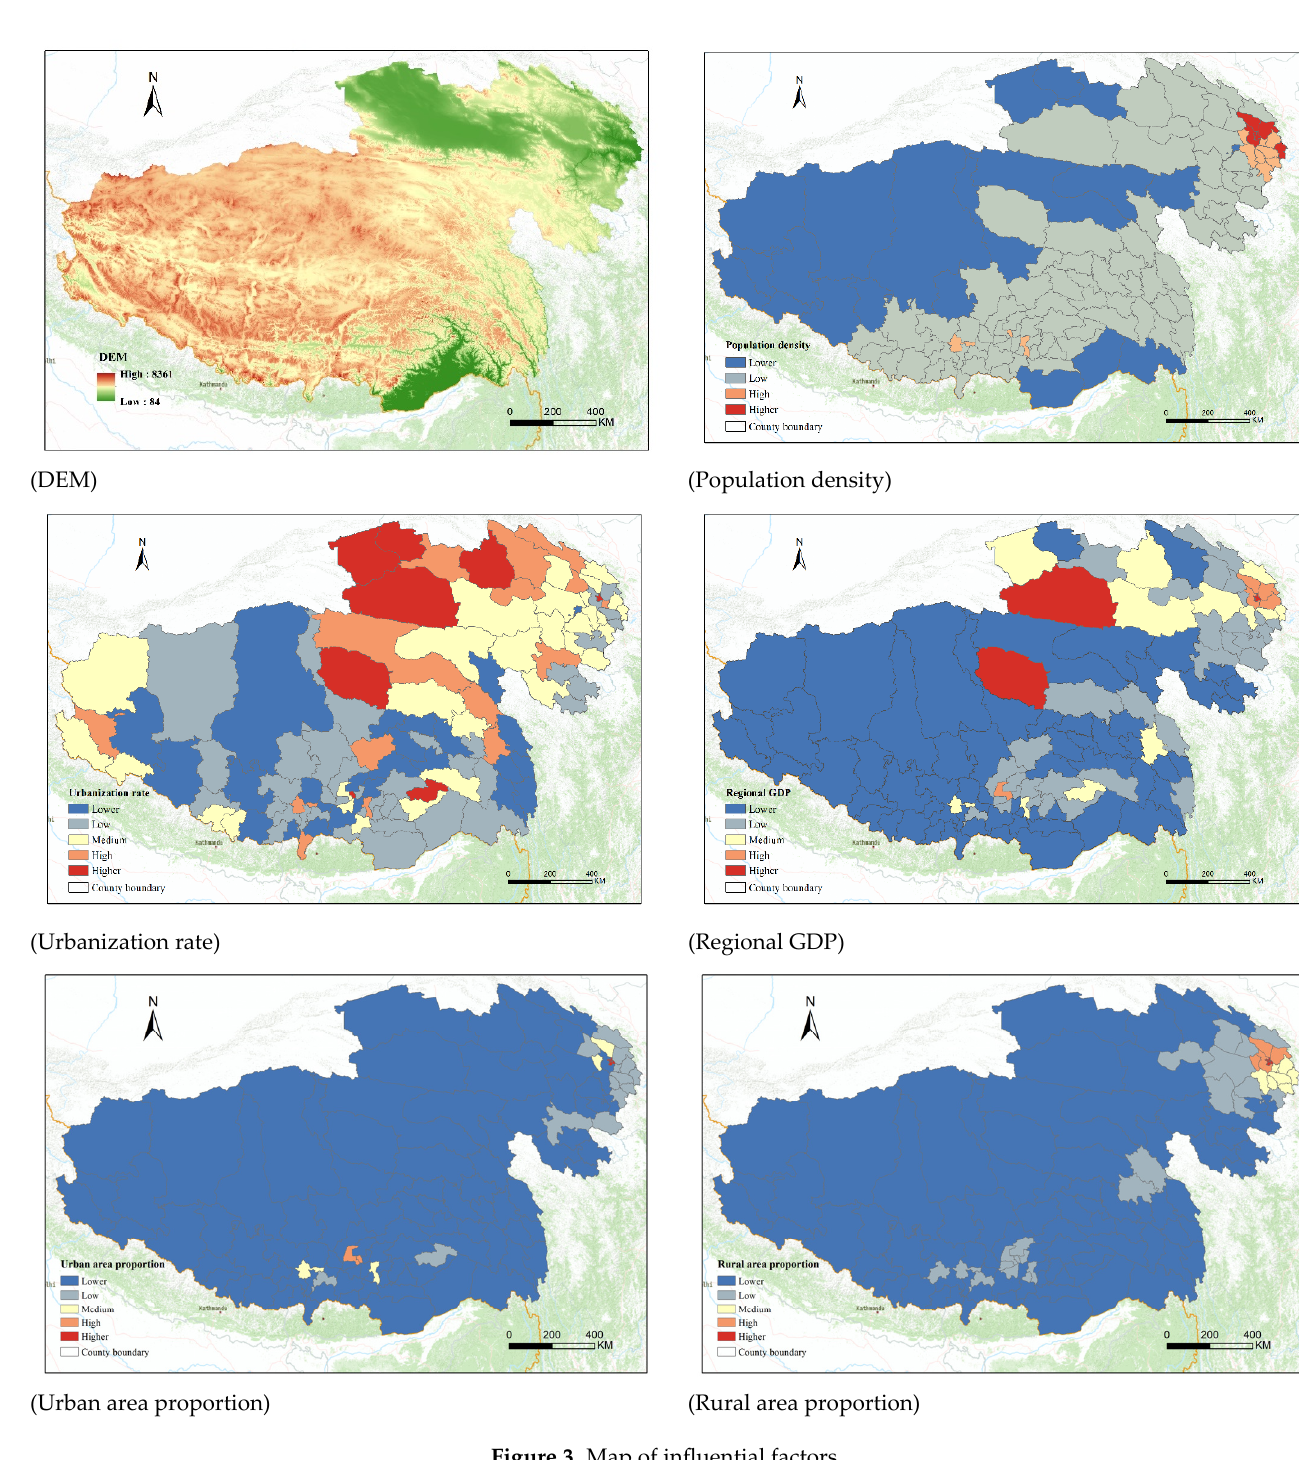
Figure 3. Map of influential factors.